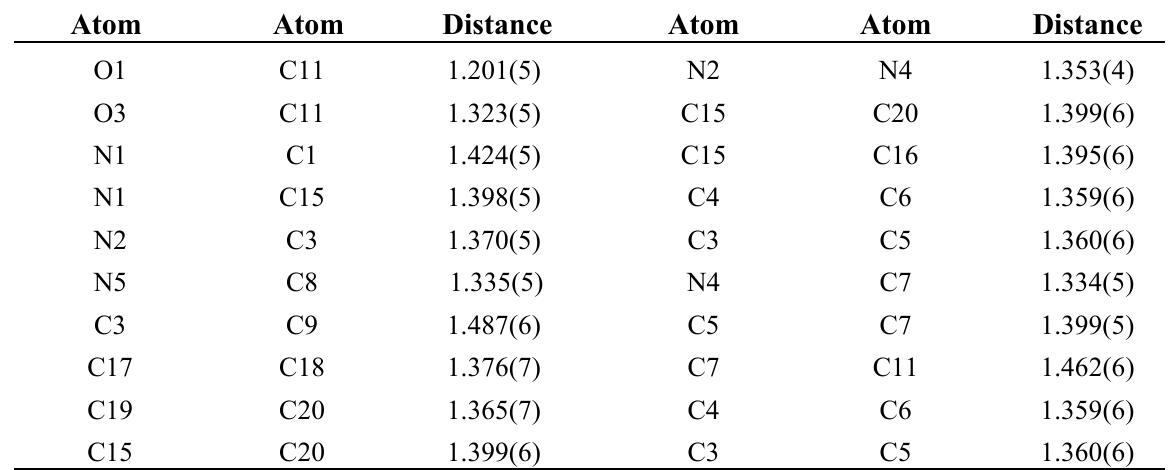
Table 3 : Selected bond distances (Å) of tripodal ligand 2 .